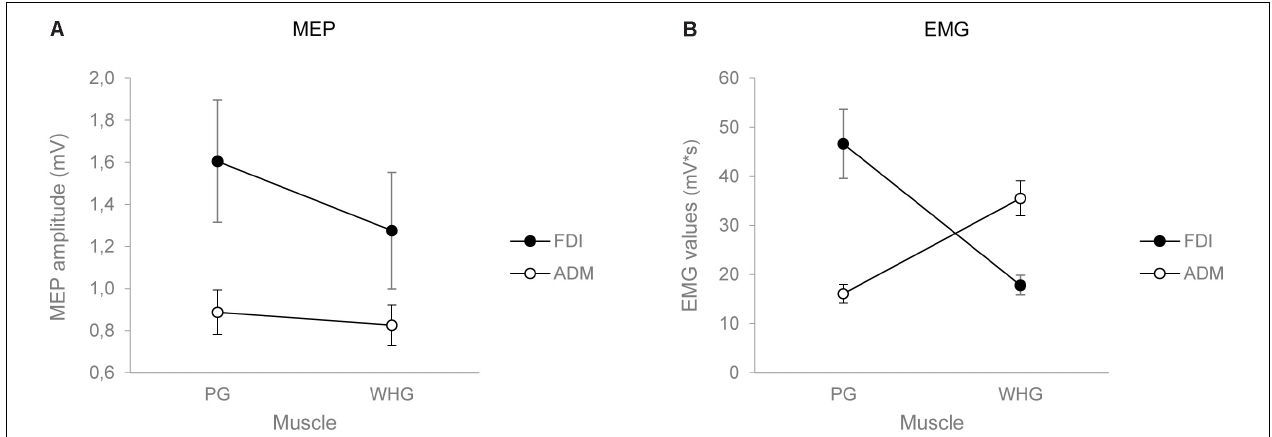
FIGURE 2 | Graphical representation of the mean values for the MEP amplitude (A) and the EMG activity in T individualized (B) for the FDI (black circles) and the ADM (white circles) muscles when participants performed either a PG or a WHG. Bars represent SE of the mean.